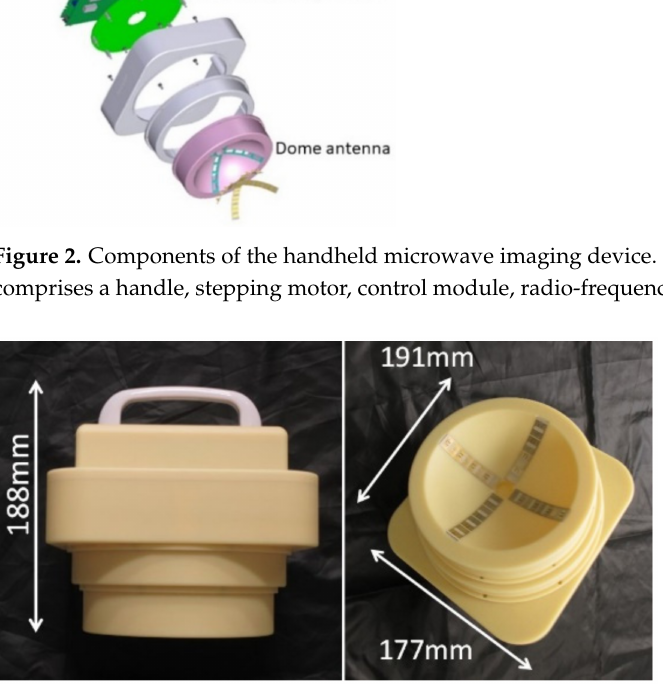
Figure 3. Appearance of the handheld microwave imaging device. The device weighs 2 kg and has dimensions of 191 × 177 × 188 mm.